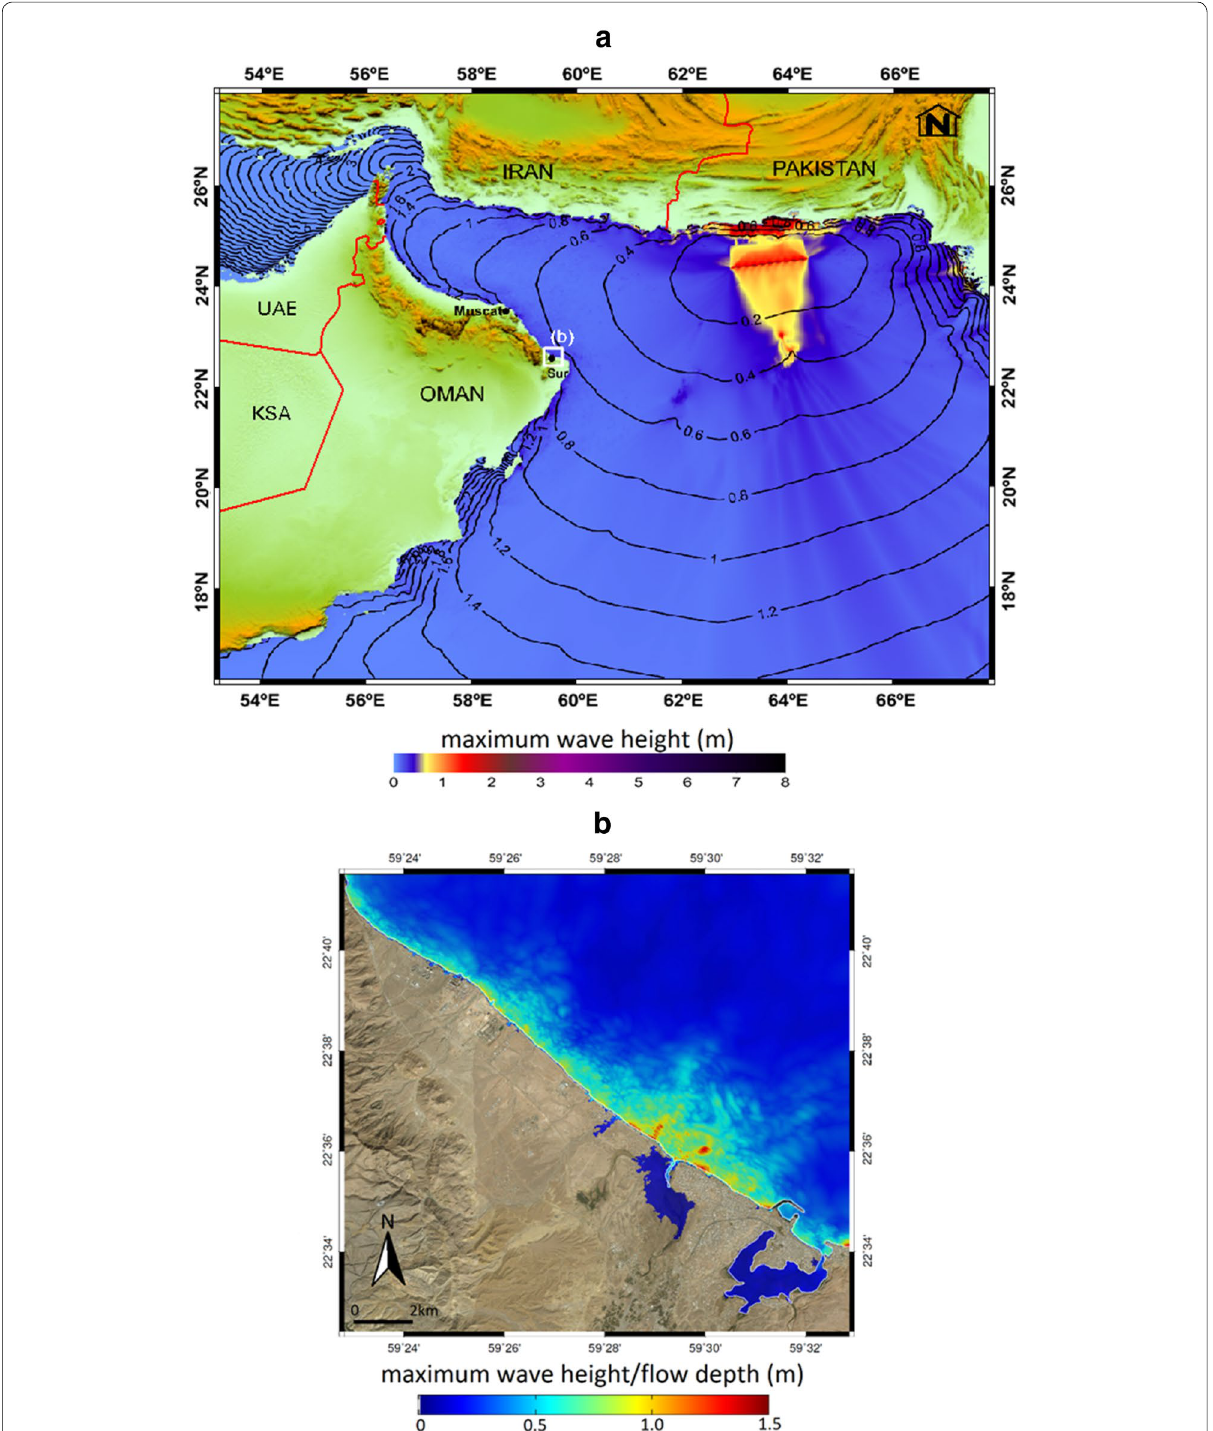
Fig. 5 a Maximum wave height distribution in the Arabian Sea following the occurrence of a Mw 8.1 1945‑like earthquake event in the eastern MSZ. The contours represent the tsunami travel time in hours plotted every 0.2 h, b maximum wave height and maximum flow depth distribution along the coastal segment Sur due to the occurrence of a 1945‑like